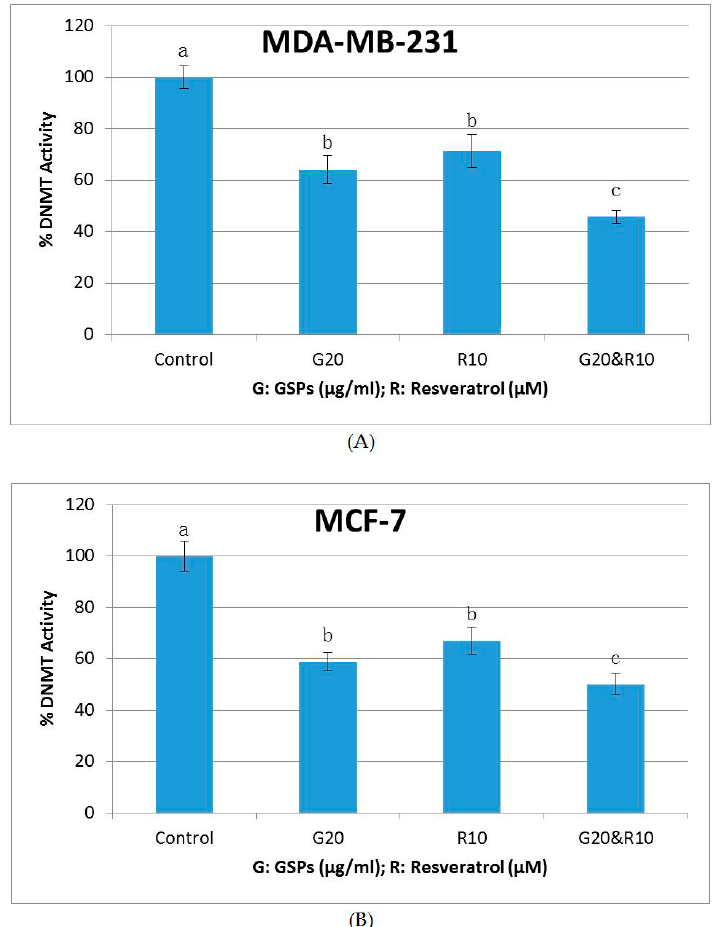
Figure 5. DNA methyltransferases (DNMT) Activity. Inhibition of DNMT activity in MDA-MB-231 ( A ) and MCF-7 ( B ) human breast cancer cells after treatment with GSPs (20 μ g/ML), Res (10 μ M),